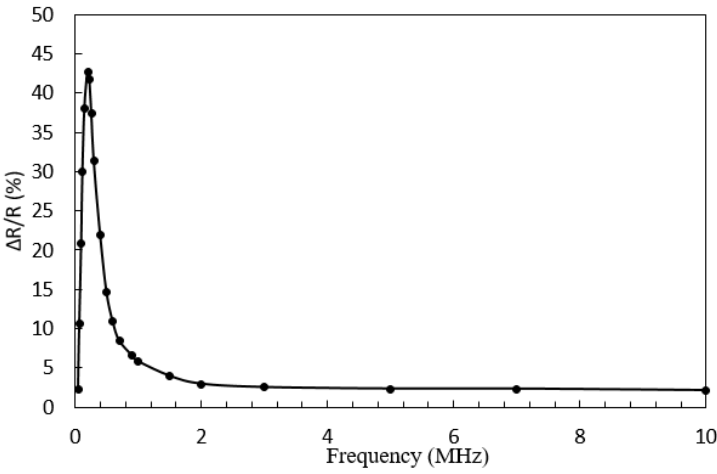
Figure 11. The frequency characteristic of the amorphous wire impedance.